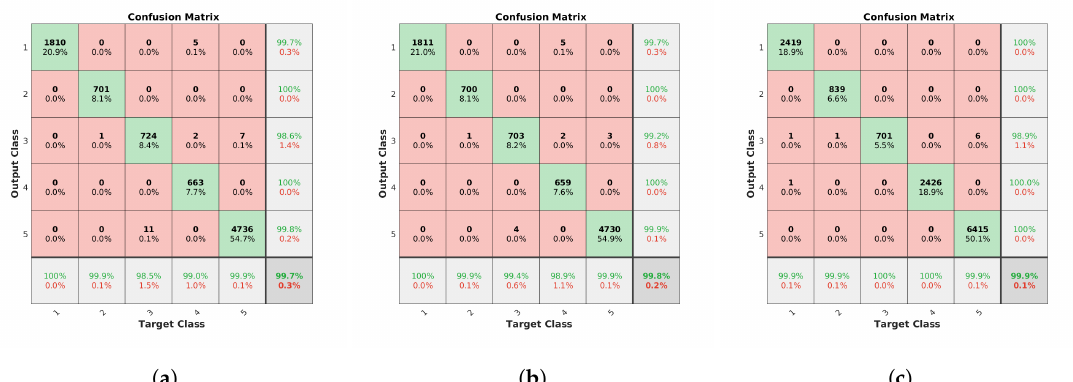
Figure 14. Confusion matrices for the model classes. Values in the diagonal indicate the number of correct matches for each class, while the rest of the values correspond to incorrect identifications depending on the expected and detected class. Percentages of correct and incorrect identifications are included in the last row and column. ( a ) Unconstrained system [31], ( b ) system with reprojection error filtering, and ( c ) system with filtering and orientation